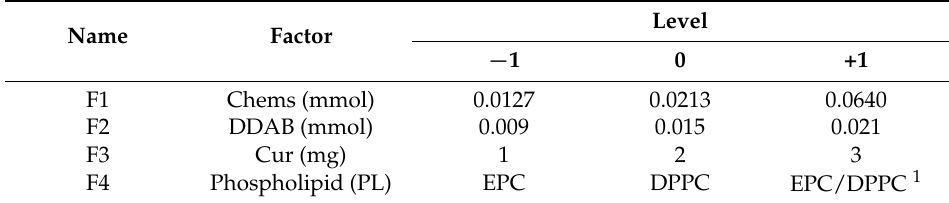
Table 1. Factors and levels selected for the experimental design. Chems: cholesteryl hemisuccinate, Cur: curcumin, DDAB: didodecyldimethylammonium bromide, EPC: l- α -Phosphatidylcholine from egg yolk.